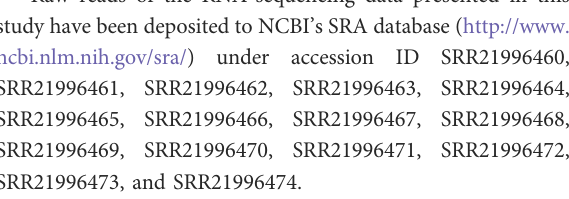
SUPPLEMENTARY FIGURE S1 Expression pro fi les of surface TLRs in monocytes versus CD8 + T cells within human blood mononuclear cells (PBMCs). Shown are representative fl ow cytometry plots of expression of different surface TLRs in monocytes and CD8 + T cells from the same PBMC sample. FMO control: fl uorescence-minus-one control. SUPPLEMENTARY FIGURE S2 Comparison of the three TLR agonists cocktail, different combinations of two TLR agonists, and anti-CD3 alone on stimulating the expression of representative proliferation-related genes in blood-derived CD8 + T cells. Related to Figure